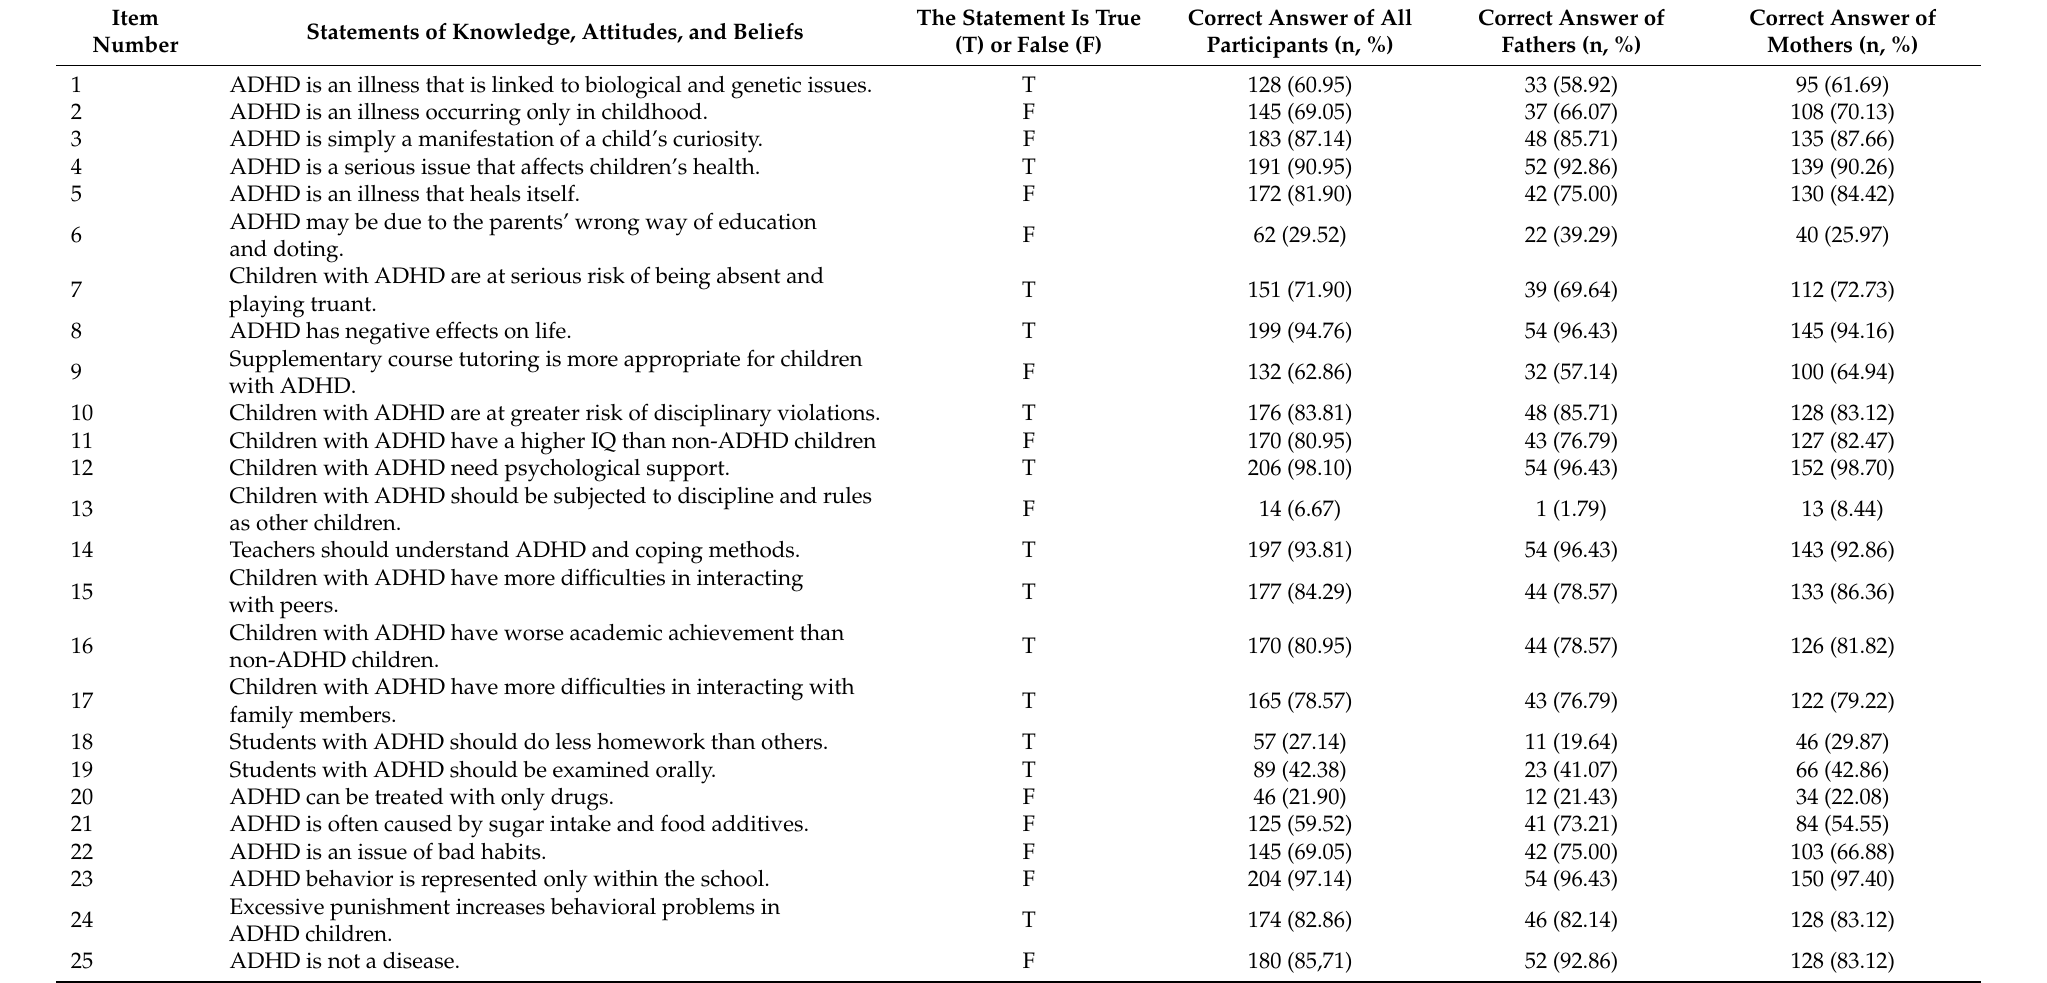
Table 2. Detailed percentage of correct answers in response to questions on knowledge, attitudes, and beliefs about ADHD (N